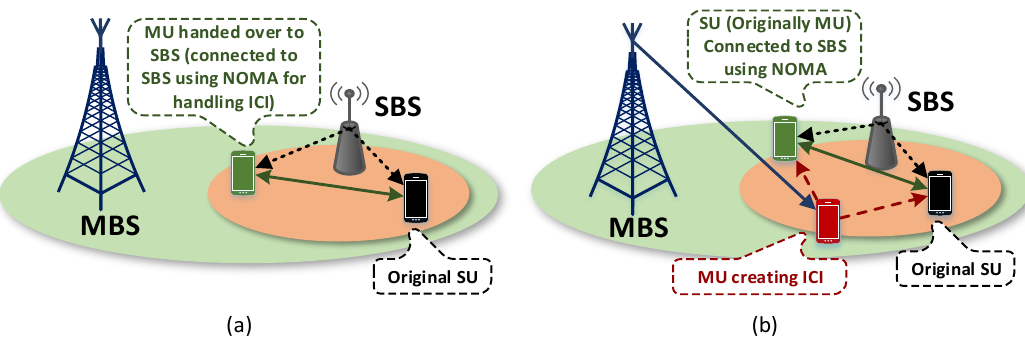
Figure 5. Simulation Scenarios: ( a ) Interfering MU connected to SBS using NOMA; ( b ) two NOMA paired SUs with one interfering MU.